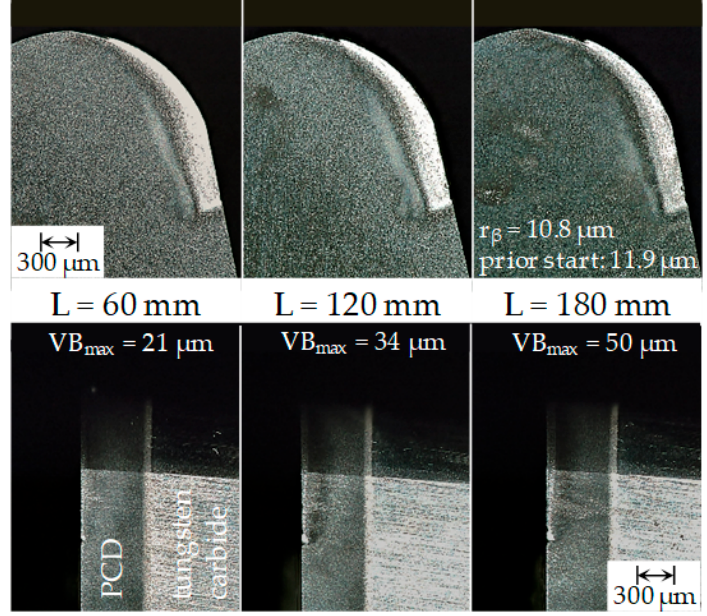
Figure 11. PCD cutting insert (external + internal cooling, flow rate internal cooling of 2200 mL/min).